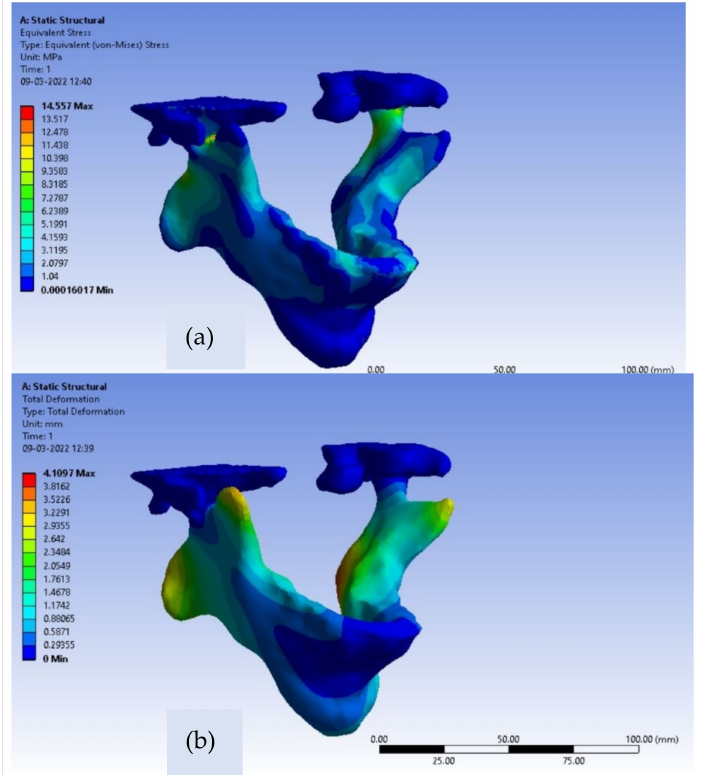
Figure 5. For intact mandible ( a ) The von-Mises stresses contours ( b ) deformations contours. Moreover, the value of maximum stress, found at the inferior part of the collar of the condyle, is far behind the ultimate strength of the adult bone in the range of 130–190 MPa [20]. For customized total TMJ prostheses, the von-Mises stress contours for Ti alloy and Co-Cr alloy are shown in Figures 6 and 7, respectively.